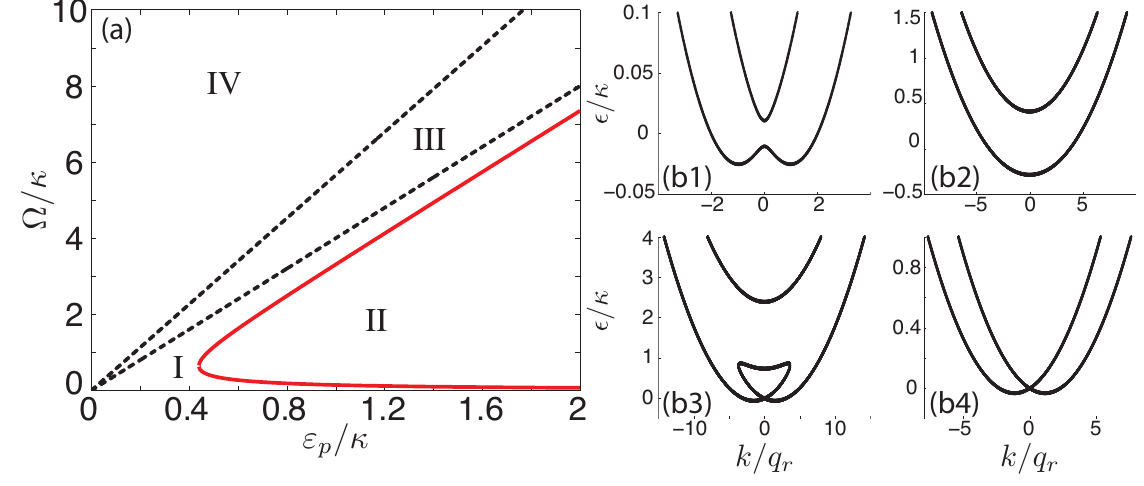
Figure 2. Single particle eigen-energy spectrum “phase diagram”. The dispersion curve is generally catagorized by four regions, represented from I to IV in ( a ). From ( b1 )